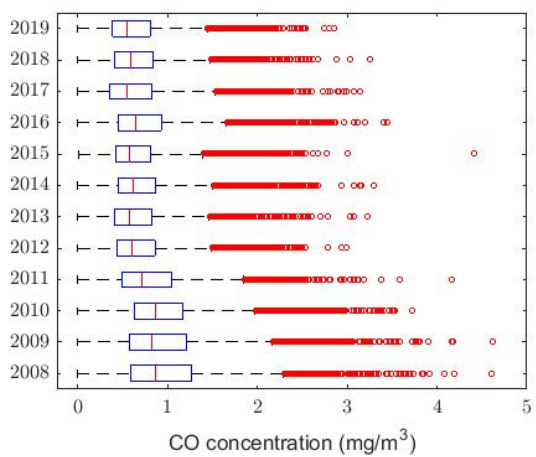
Figure 1. Box plot diagram of all years. The red circles represent the outliers.